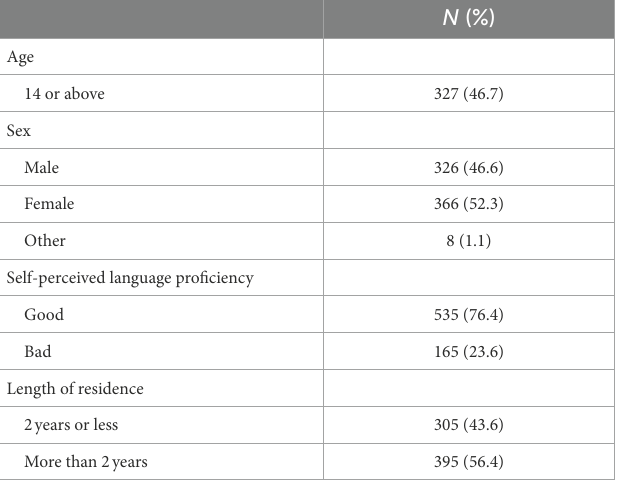
TABLE 3 Socio-demographic characteristics of migrant adolescents.